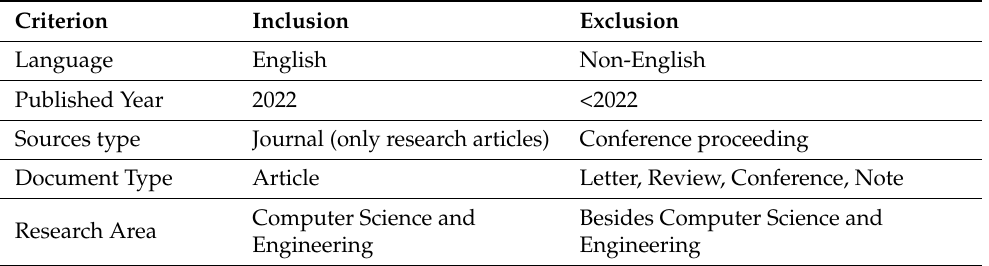
Table 2. The selection criterion for searching.